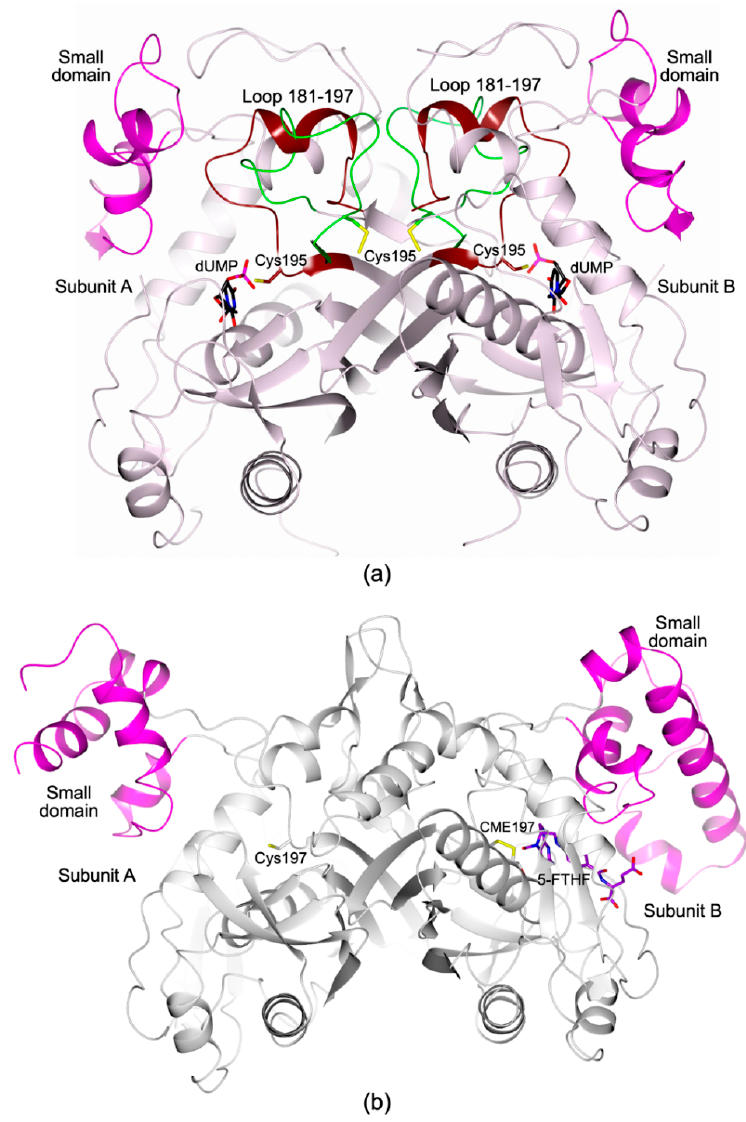
Figure 1. ( a ) Cartoon representation of the hTS homodimer in the active (PDB id 1HVY [3]) and inactive conformations (PDB id 1YPV [4]; for the inactive conformation, only the catalytic loop, including residues 181–197, is shown for clarity). In both subunits, the large and small domains are coloured light pink and dark pink, respectively. The two orientations of the catalytic loop (residues 181–197), defining the active (brown trace, PDB id 1HVY [3]) and inactive (green trace, PDB id 1YPV [4]) enzyme conformations, are displayed. The catalytic cysteine is shown in sticks (brown and green carbons in the active and inactive conformations, respectively). The position of the catalytic cavity is indicated by the presence of the substrate 2’-deoxyuridine 5’-monophosphate (dUMP, in sticks, black carbons). ( b ) Cartoon representation of the Ef TS homodimer (PDB id 3UWL [5]). In both subunits, the large and small domains are coloured white and dark pink, respectively. The large domain (residues 1–68 and 139–315), representing the conserved core of the enzyme, shows an α / β structure generated by seven α -helices and eight β -strands. The small domain (residues 69–138) are only fully structured (five α -helices connected by short loops) in the enzyme subunit with the cofactor binding site populated by 5-formyl-6-tetrahydrofolate (5-FTHF, in sticks, purple carbons). In the partner subunit, the small domain is highly flexible and only partially visible in the structures. The position of the active site is indicated by the catalytic Cys197 (in sticks, white carbons; in subunit B, it is modified as S,S-(2-hydroxyethyl)thiocysteine, CME197). In all figures, nitrogen atoms are coloured blue, oxygen red, sulphur yellow, and phosphorous magenta.